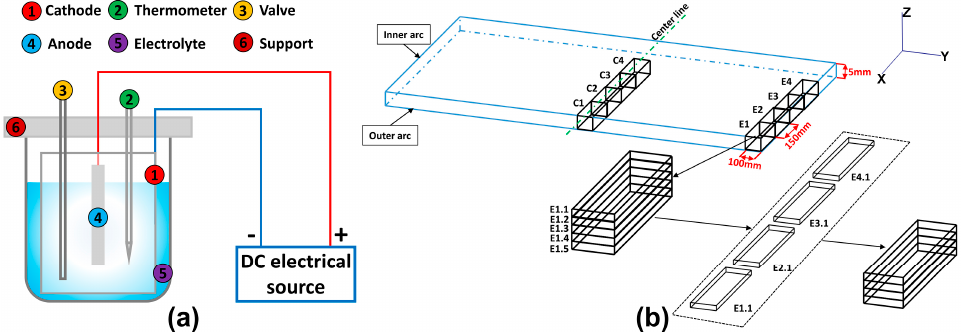
Figure 6. Schematic diagram for galvanostatic electrolysis method ( a ) and sample machine process ( b ).